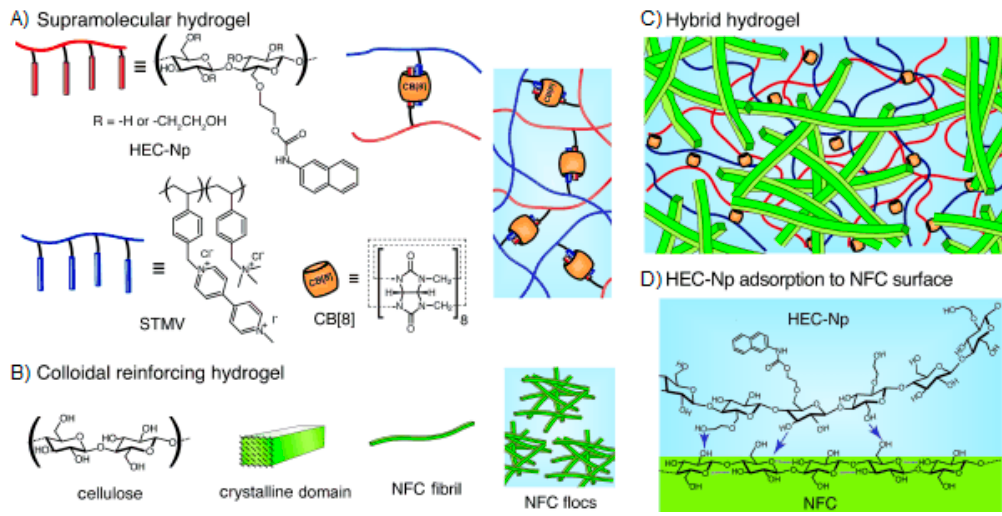
Figure 9. ( A ) Supramolecular hydrogel consisting of HEC-Np, STMV, and the CB[8] host motif capable of binding the first guest naphthyl and the second guest viologen highly dynamically; ( B ) Colloidal reinforcing nanofibrillated cellulose, also showing the denser and less dense network regimes; ( C ) Interpenetrating hybrid hydrogel consisting of the molecular-level supramolecular and colloidal-level NFC hydrogel; and ( D ) Surface adsorption of HEC-Np onto the NFC surface. Possible hydrogen bonding is schematically shown. Reprinted with permission from [122]. Copyright 2016 John Wiley and